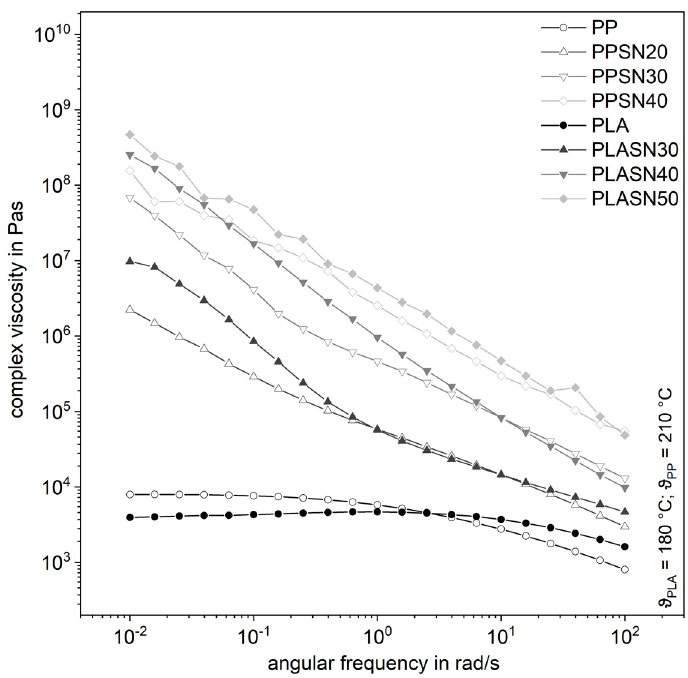
Figure 7. Influence of the plastic matrix on the complex shear viscosity of the compounds with the smaller fused silica (SN).